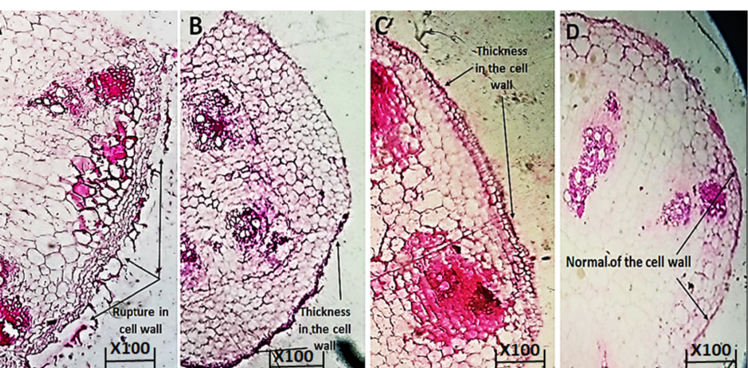
Figure 7. Effect of Cu 2 ONPs on the anatomical structure of cucumber root infection with F. solani. ( A ): infected control with F. solani, ( B ): Cu 2 ONPs (0.35 M), ( C ): Cu 2 ONPs (0.30 M) and ( D ): uninfected.